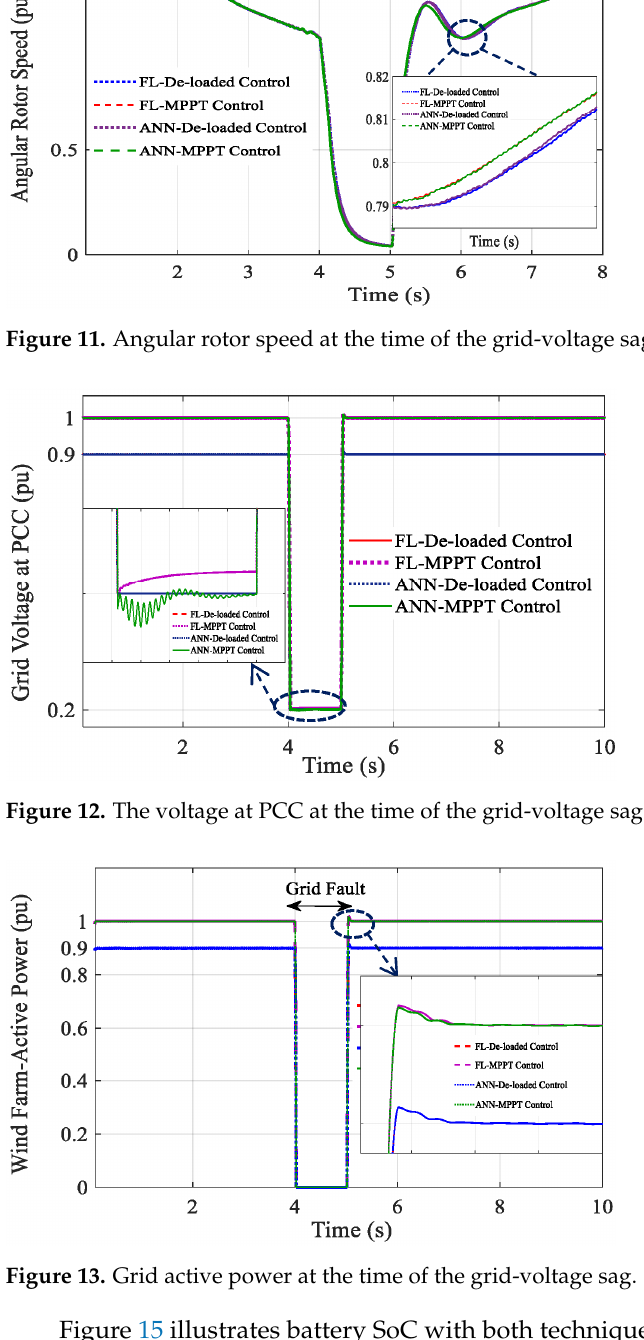
Figure 11. Angular rotor speed at the time of the grid-voltage sag.